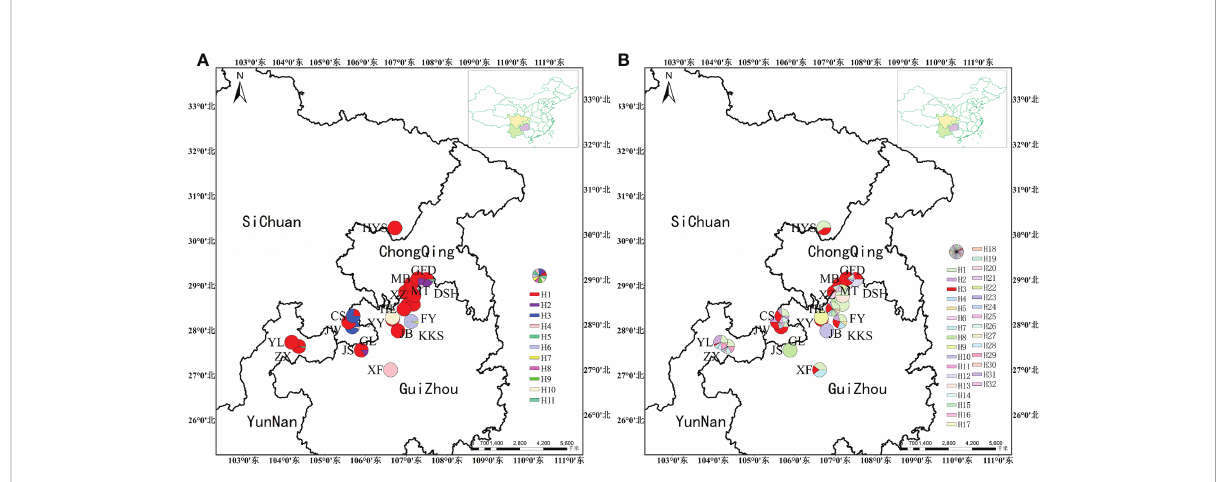
FIGURE 2 Geographic distribution of haplotype based on cpDNA (A) and nrDNA (B)